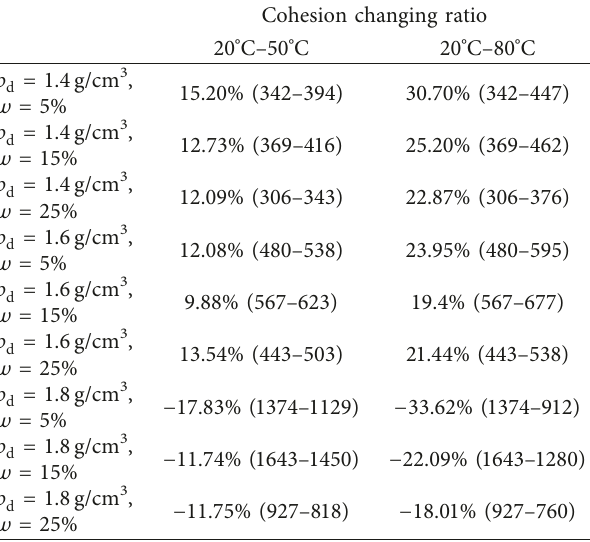
Table 6: The cohesion change of GMZ001 bentonite with tem- perature